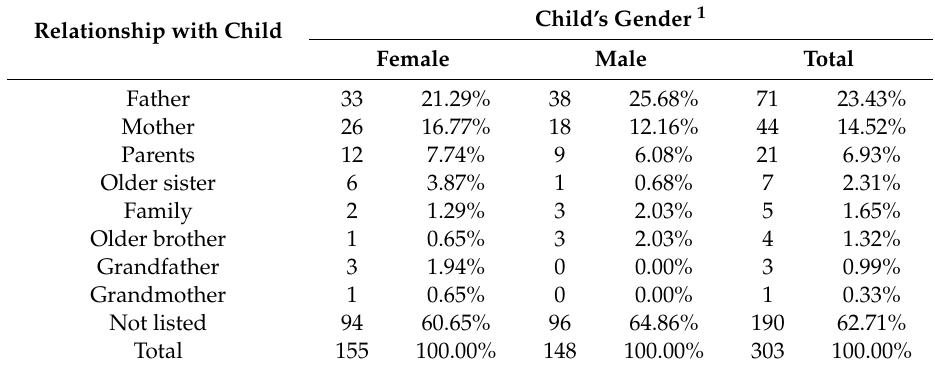
Child’s Gender 1